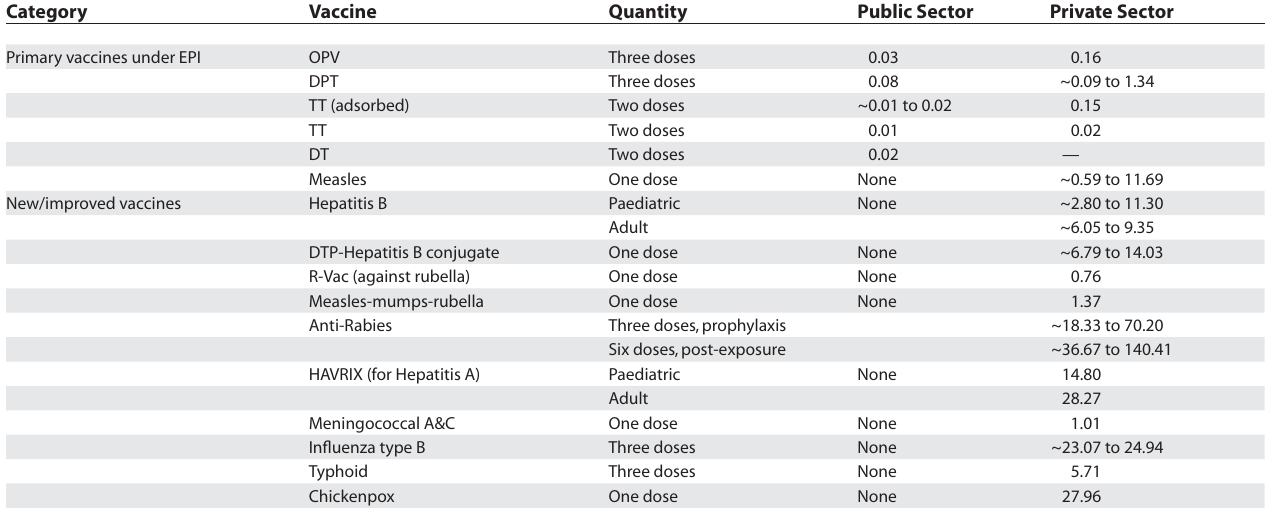
Table 2. Cost of Full Immunisation with Each Vaccine (in US dollars) Category Vaccine Quantity Primary vaccines under